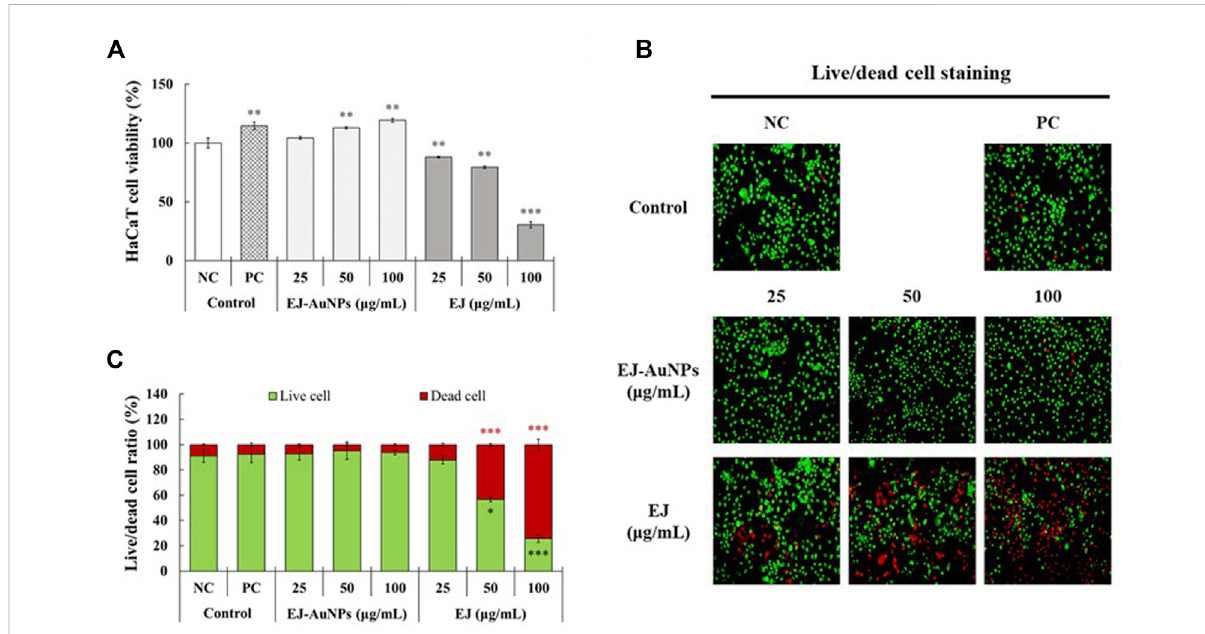
FIGURE 6 Cytotoxic effects of EJ and EJ-AuNPs against HaCaT keratinocytes. (A) The MTT assay. (B) Microscopic images and their (C) quanti fi ed results stained by live/dead cell staining dye. Live and dead cells were stained with green and red colors, respectively. NC, negative control treated